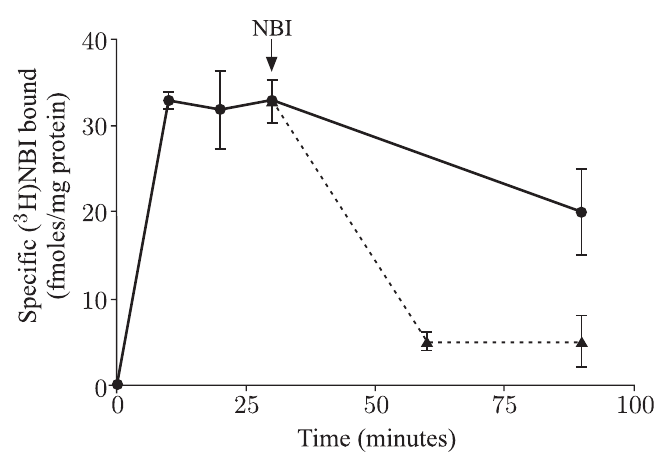
Fig. 3 – Time profile of specific ( 3 H)NBI binding to adenosine transporters in cultures of chick retinal cells. Cultures were incubated for 6 days and incubated with saline containing ( 3 H)NBI (10 nM) in the absence or presence of unlabeled NBI ( 10 µ M ) for determination of specific binding. Maximal binding was ob- served after 10 minutes and was stable for at least more 20 minutes. The addition of unlabeled NBI after 30 minutes of incubation was able to displace ( 3 H)NBI binding (dashed line) from cultured cells, indicating the binding to surface sites.